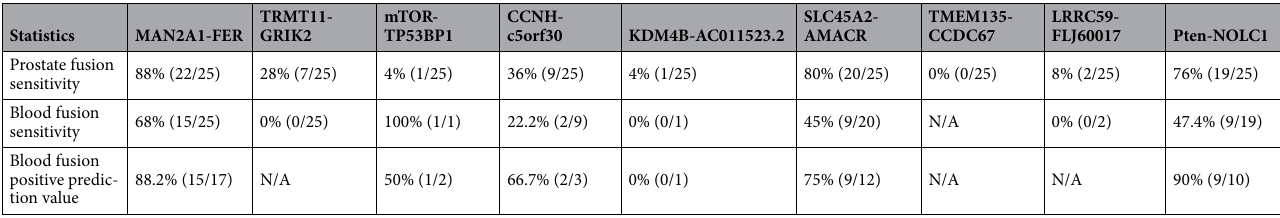
Table 2. Concordance statistics of the matched prostate cancer and blood